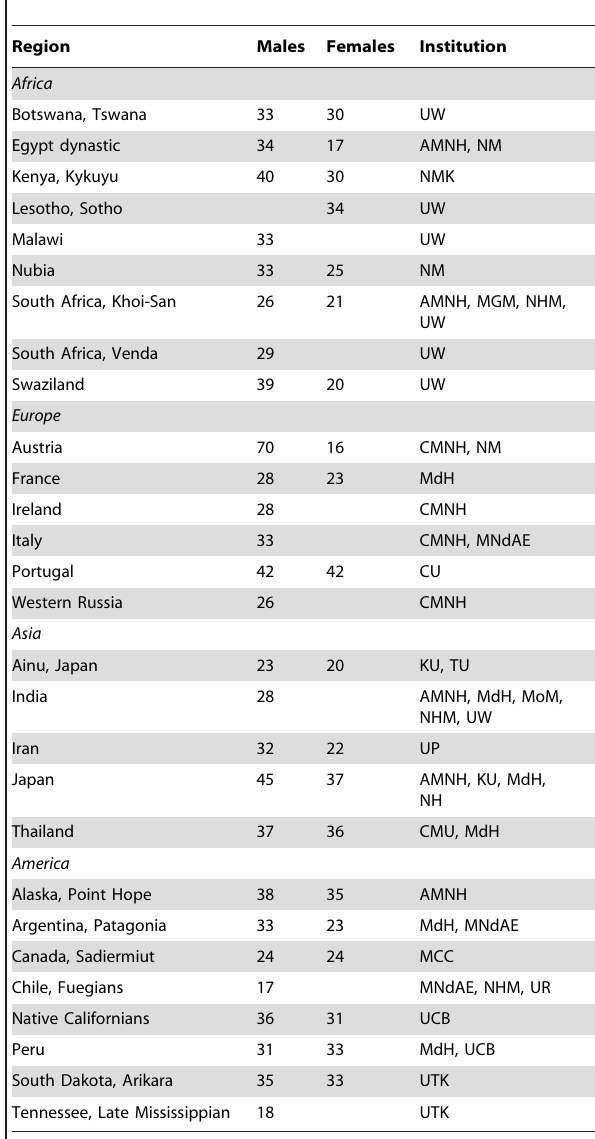
Table 1. Population samples and institutions where material is